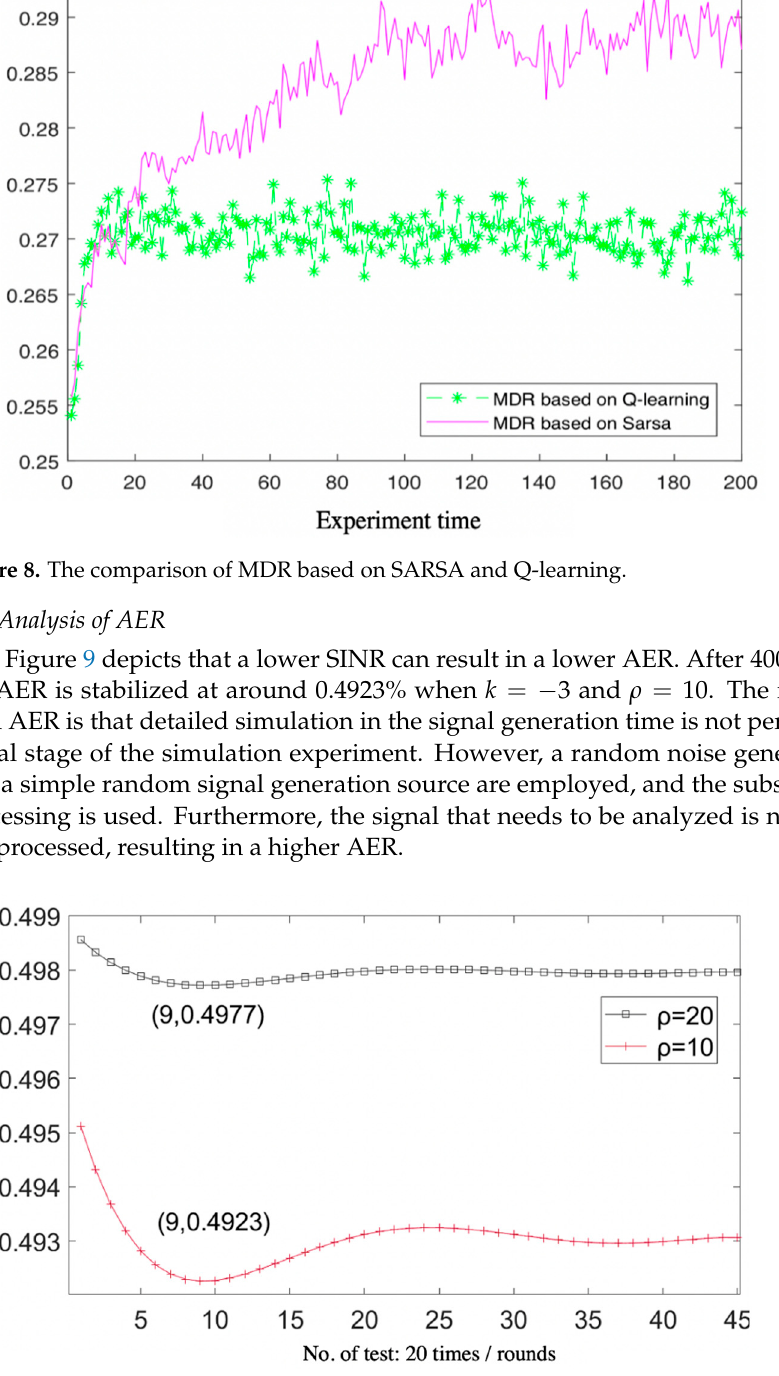
Figure 9. When 𝑘 = −3 , the AER at 𝜌 = 20 and 𝜌 = 10 are tested separately. The Q table is up- dated 20 times per round as the number of experimental rounds increases.